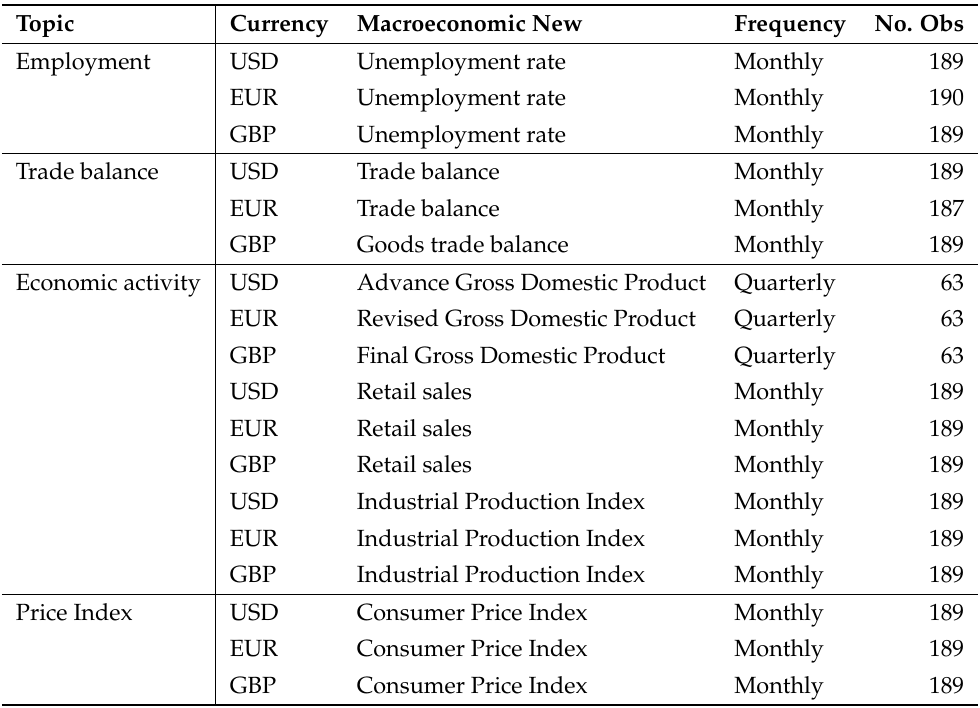
Table 1. Summary of selected macroeconomic news by topic, region, and frequency from January 2007 to September